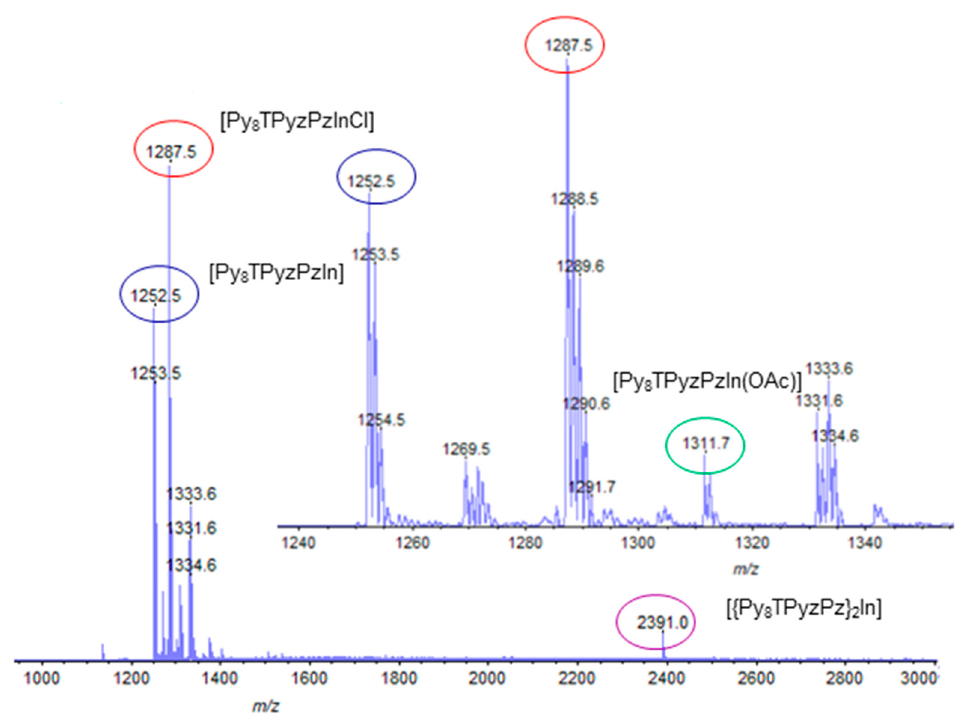
Figure 4. Mass spectrum of the complex [Py 8 TPyzPzIn(OAc)]·8H 2 O. The spectrum in the inset shows the expanded range m / z 1240–1350.